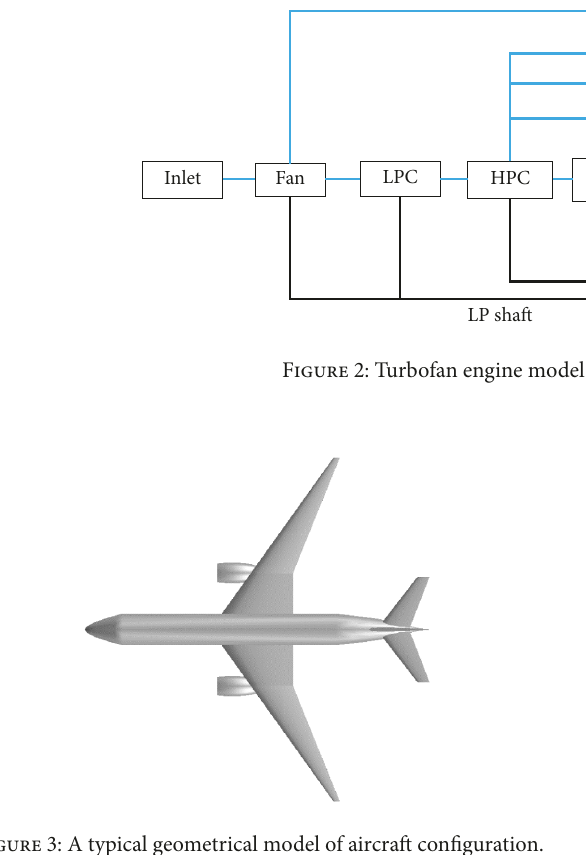
settings for maximum takeoff, maximum climb, maximum continuous, maximum cruise, and idle